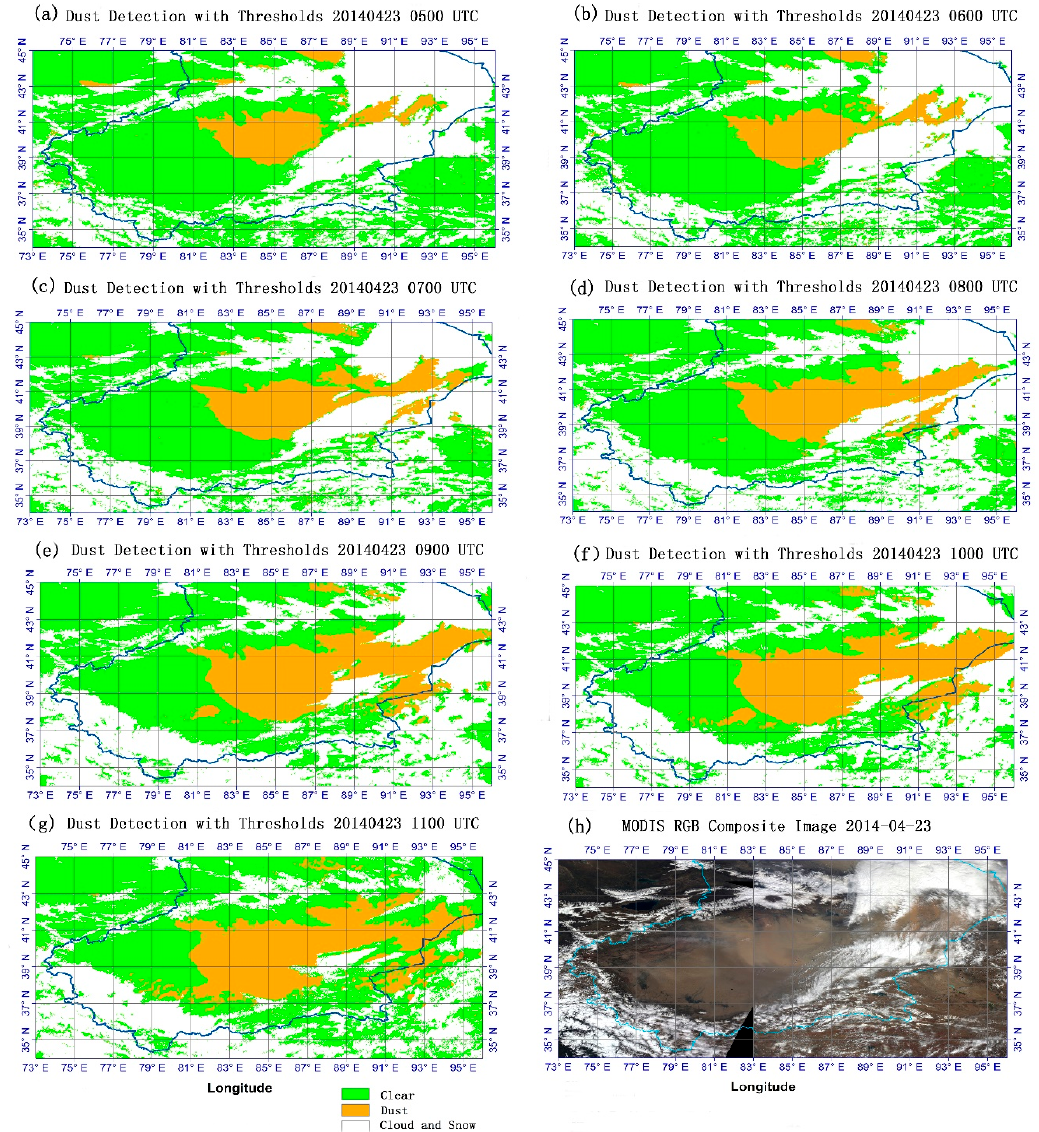
Figure 11. Dust detection images (from 5:00 UTC to 12:00 UTC) calculated with the thresholds method during a dust storm event on 23 April 2014. MODIS RGB image taken at 5:00 UTC on 23 April 2014. ( a – g ) are the results of thresholds method per hour from 5:00 UTC to 11:00 UTC, in 23 April 2014, and ( h ) is the MODIS RGB image at 5:00 UTC, in 23 April 2014.